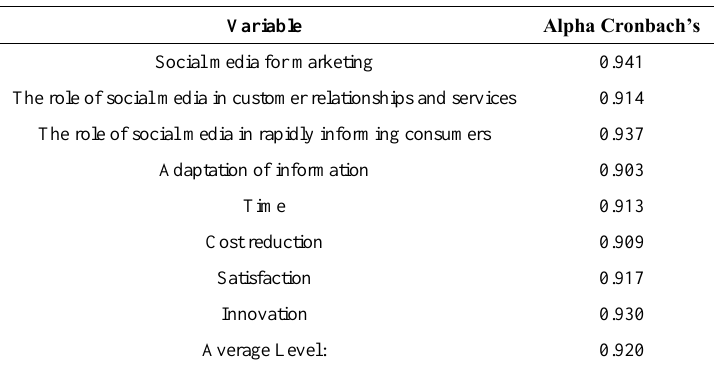
Table 4. Value of Alpha Cronbach’s.